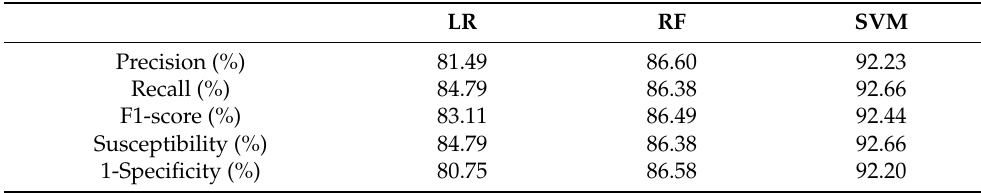
Table 3. Comparison of model